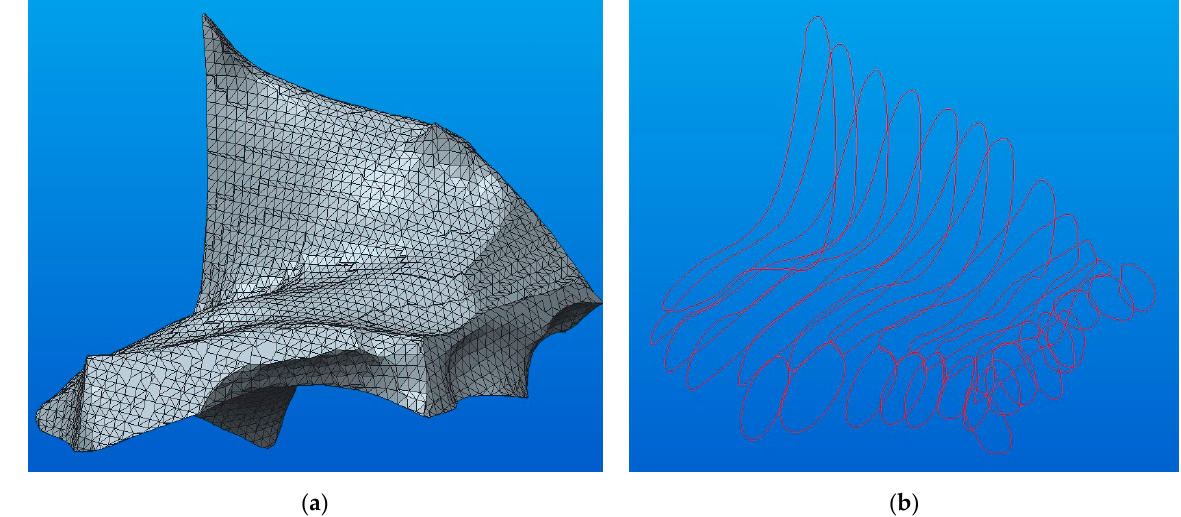
Figure 11. The A component tracing: ( a ) Shrinkwrap model; ( b ) sketches necessary for modeling.